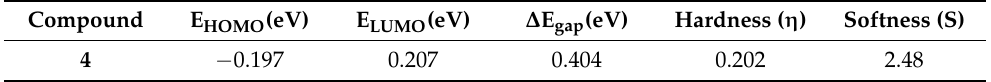
Table 5. Energetic Parameters of the selected Compound.